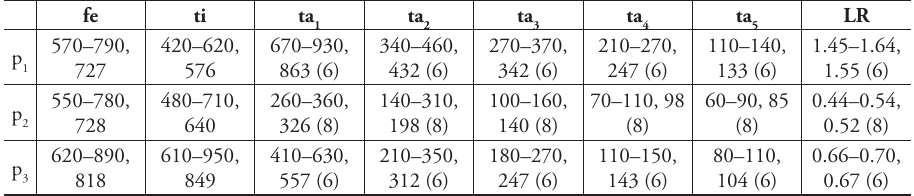
Table 2. Lengths (µm) and proportions of adult male legs in Parachironomus monochromus (van der Wulp)